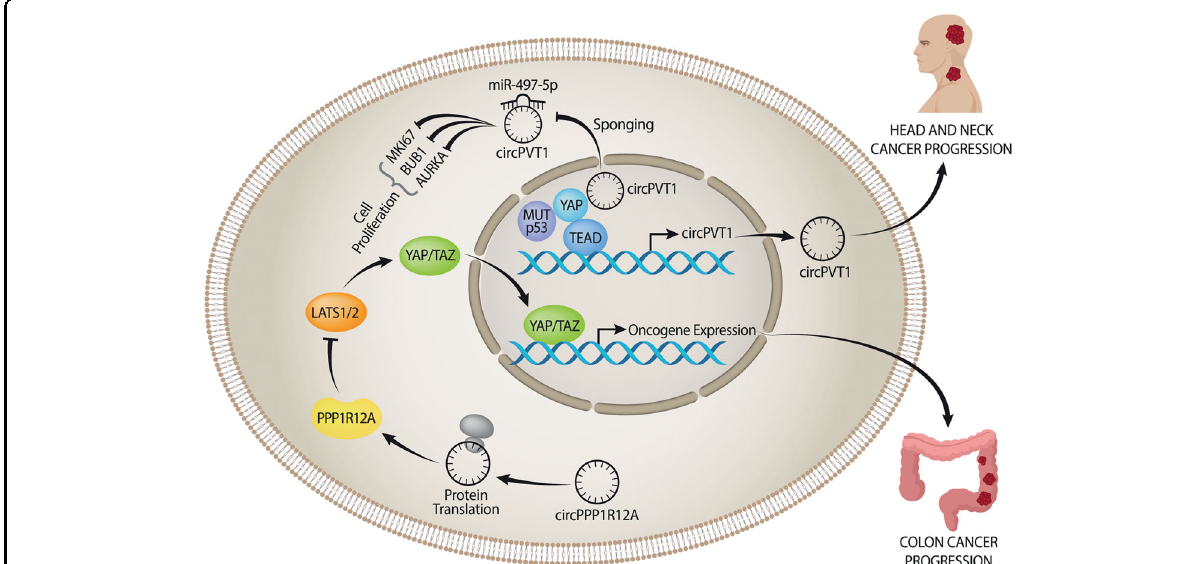
Fig. 4 circPVT1 and circPPP1R12A working in the Hippo signaling pathway. The circPVT1 acts as oncogene in head and neck squamous cell carcinoma sponging the miR-497-5p and binding the complex YAP/mutp53. The circPPP1R12A can be translated into a protein and acts as oncogene in colon cancer where it is able to activated the proliferation of the tumor cells via theHippo-YAP